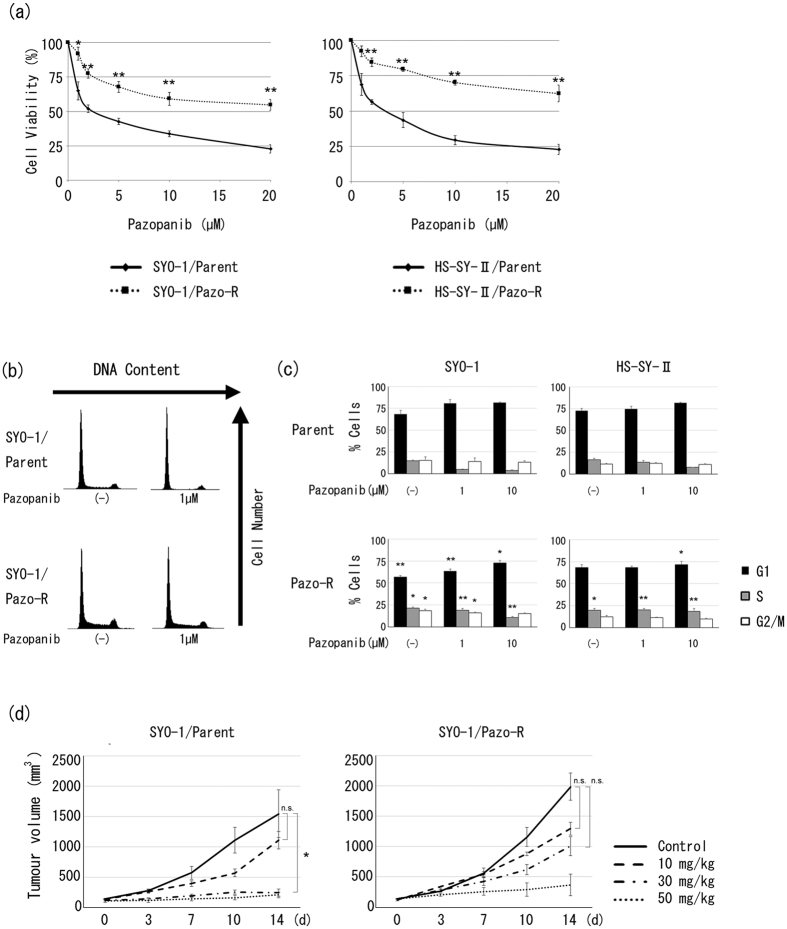
Establishment of pazopanib-resistant SS clones.(a) SS clones were incubated with various doses of pazopanib for 48 hours. Viable cells were counted using a Z1 Coulter particle counter. Values represent mean ± S.D. *P < 0.05; **P < 0.01, vs parental clones. (b,c) Cells were incubated with pazopanib (0, 1, and 10 μM) for 24 hours and fixed in 70% ethanol. After staining with PI, the DNA content of each phase (e.g., G1, S, or G2/M) was analysed by flow cytometry. Values represent mean ± S.D. *P < 0.05; **P < 0.01, vs parental clones. (d) Pazopanib resistance of SYO-1 parental and pazopanib-resistant clones in vivo. Values represent mean ± S.D. *P < 0.05; n.s. not significant, vs pazopanib-free condition. Pazo-R represents pazopanib-resistant clone.